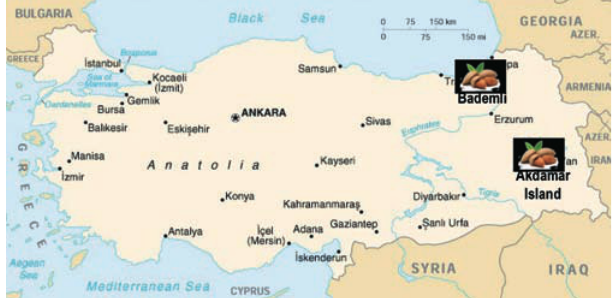
Figure 1. Map of Turkey, the origin of Turkish almond accessions (Bademli and Akdamar Island) are signed with small almond